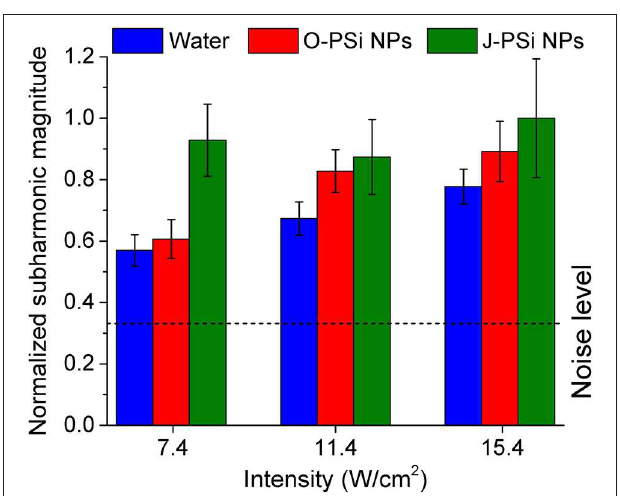
FIGURE 7 | Mean subharmonic magnitudes in distilled water and the suspensions of O-PSi NPs and J-PSi NPs during 200s of exposure to US at three different intensities. The dashed line corresponds to the noise level. The error bars indicate s.d. (significance level α =